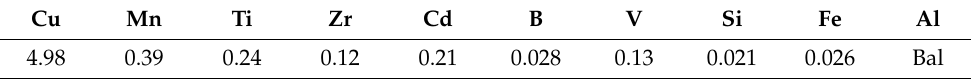
Table 1. Chemical composition of ZL205A Al-Cu alloy